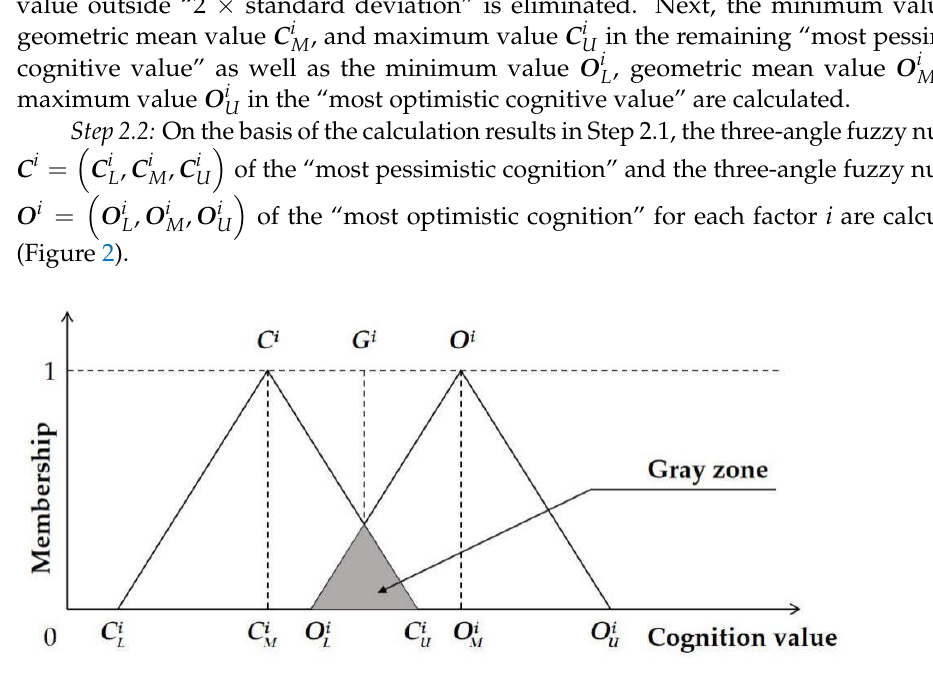
Figure 2. Triangular fuzzy numbers formed using the fuzzy Delphi method (FDM).